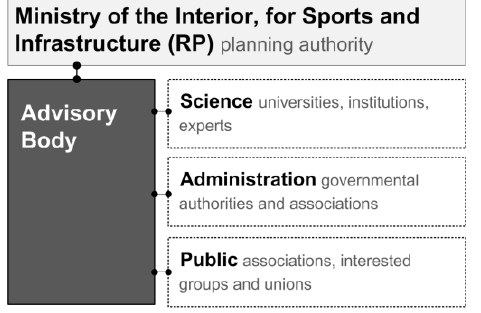
Figure 1. Members of advisory body.